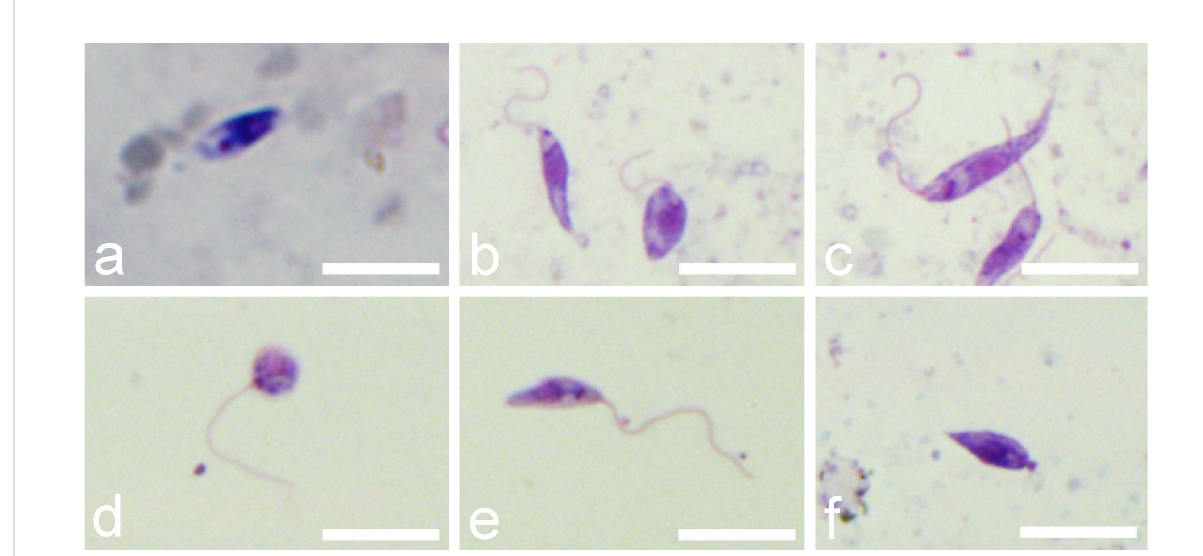
FIGURE 5 Morphological forms of P. deanei present in gut smears of infected L. longipalpis . (A) , procyclic promastigote; (B) , leptomonad forms; (C) , elongated nectomonad; (D) , round metacyclic form; (E) , slender metacyclic form; (F) , haptomonad. Scale bars indicate 10